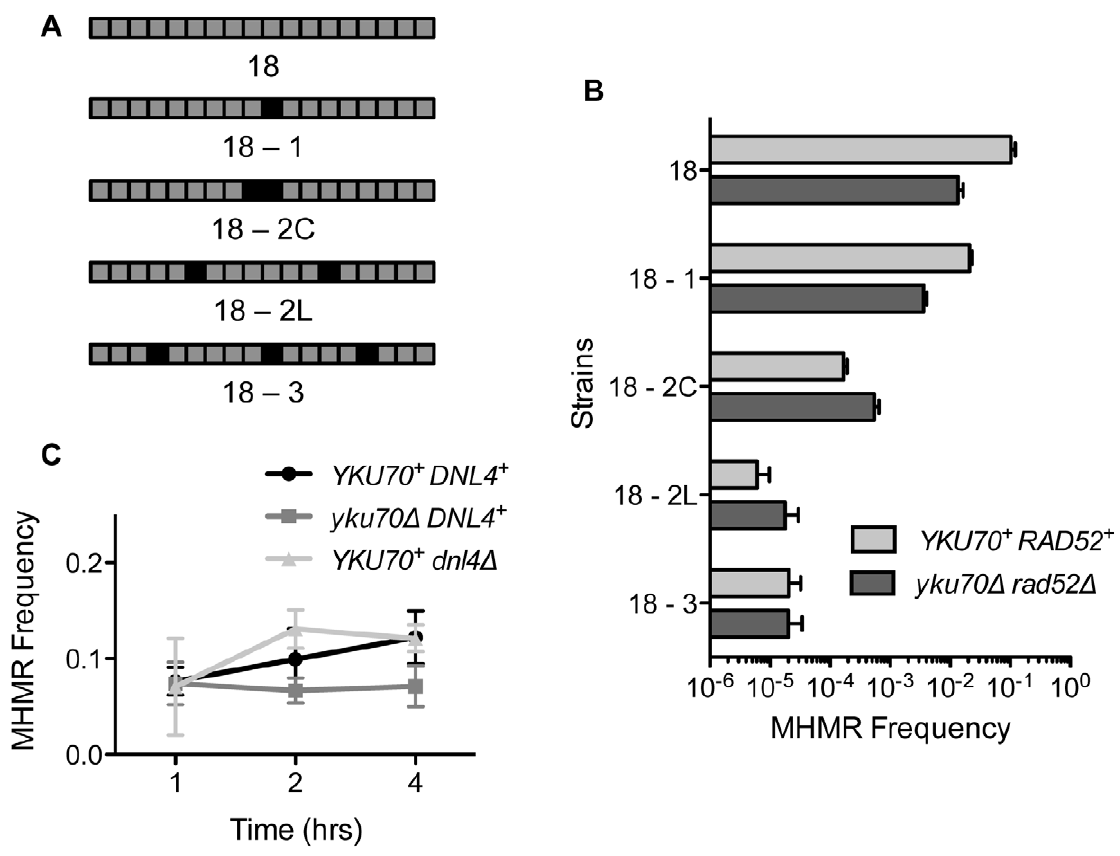
Figure 3. Mismatched microhomology inhibits repair efficiency, but NHEJ does not inhibit MHMR. (A) Illustration of strains with mismatched sequences. Black boxes indicate mismatched nucleotides. (B) MHMR frequency using 18 bp mismatched microhomology 2 kb from the DSB in wild type and yku70 D rad52 D . Survival frequency was calculated as shown in Figure 1B. The results are the average of three independent experiments 6 S.D. (C) Graph showing MHMR frequency using the 17 bp of microhomology located 2 kb from the DSB in wild type, yku70 D and dnl4 D mutants. Survival frequency was calculated as shown in Figure 1B. The results are the average of three independent experiments 6 S.D. lys2::Ins(A4) gene 36 kb from the HO cut-site flanked by 17 bp microhomology and measured the frequency of LYS2 reversion (Figure 4A) [52]. As predicted, HO expression elevated ( , 100 fold) the LYS2 frameshift mutation frequency in the strain AM1291 that repaired a DSB by BIR [52]. However, the LYS2 frameshift mutation did not increase after HO expression in the strain bearing microhomology flanking the break site (Figure 4B).